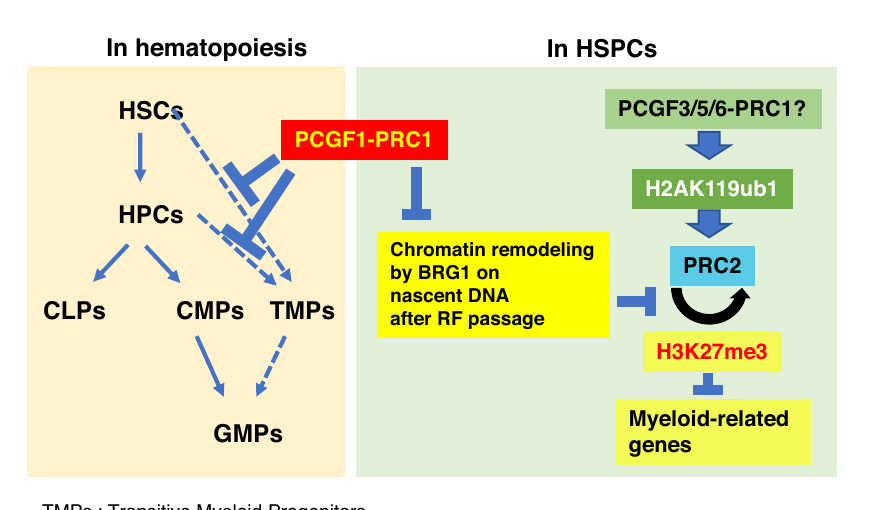
Fig. 6 | Association of PCGF1 with the replication fork limits access of chro- matinremodelers.a AscatterplotviewforPCGF1interactorsinIdHPCs.TheXand Y axes denote log2 signal intensities of proteins in the mock immunoprecipitation (thenegativecontrol:NC)andlog2ratiosofthelabel-freequanti fi cationintensities of immunoprecipitatedmaterials overthe negativecontrol (log2 FC),respectively. Orangefontdenotesproteinswithlog2FC>0.3.Datarepresenttheaverageoftwo independent experiments. b Proximity Ligation Assay (PLA) revealed association between 3xFLAG-tagged PCGF1 and EdU-labeled nascent DNA. Pcgf1 -KO IdHPCs with or without exogenous Pcgf1 were used. PLA, red; DAPI, blue. Representative datafrombiologicaltriplicatesareshown. c AheatmapofChIP-seqandiPOND-ChIP signals for endogenous TY1-PCGF1 across TSS (±10kb) in IdHPCs. Data represent theaverageoftwoindependentexperiments. d ScatterplotofiPOND-MSincontrol and Pcgf1 -KO IdHPCs. The X and Y axes indicate log2 intensities of the control and log2 ratios of signal intensity of Pcgf1 -KO over the control, respectively. Repre- sentativedatafromtwoindependentbiologicalduplicatesareshown.Blueandred fonts, respectively, indicates proteins with log2 FC< − 0.4 and log2 FC>0.4.